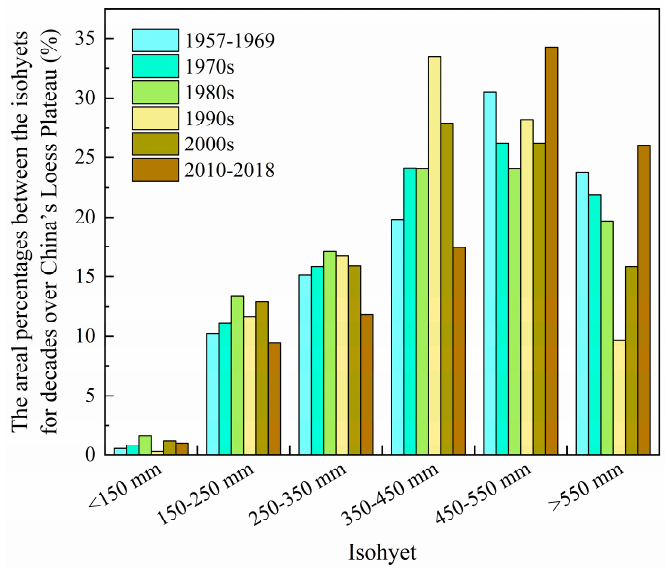
Figure 5. The areal percentages between the isohyets for decades over China’s Loess Plateau.